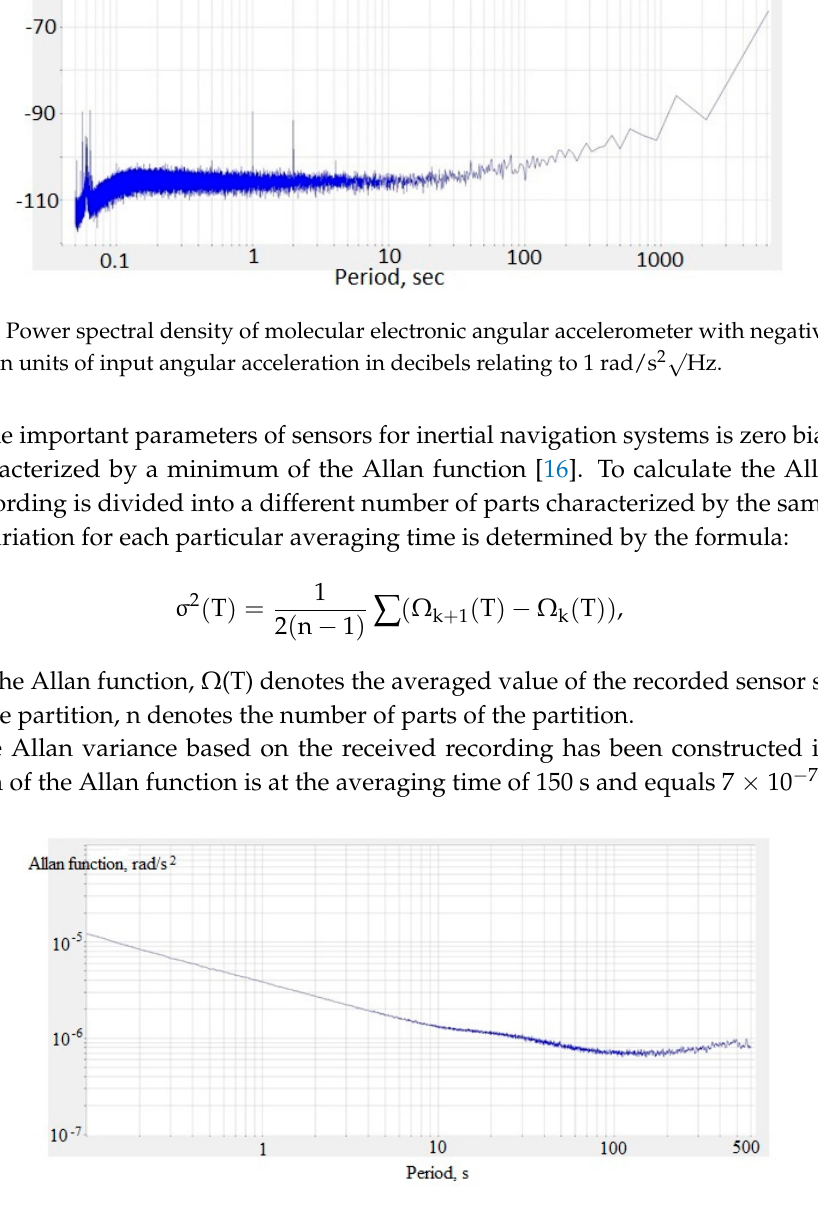
Table 1. Comparison of the obtained main characteristics with the analogues.